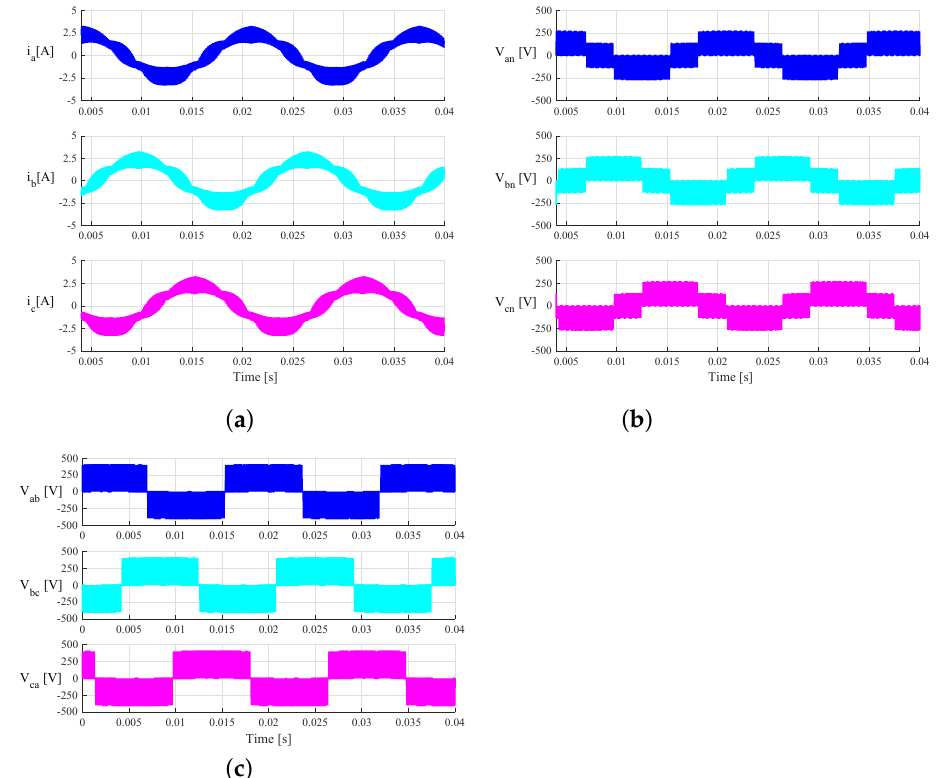
Figure 10. Output currents and voltages of the three-phase DCM-232 inverter under SVM-CSSVM technique. ( a ) Three-phase output currents, ( b ) line-to-neutral voltages, and ( c ) line-to-line voltages.